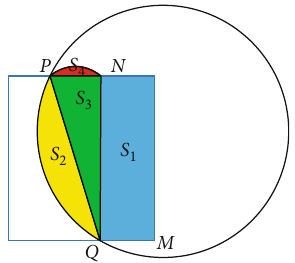
Figure 3: A typical case of a spherical disk intersecting a